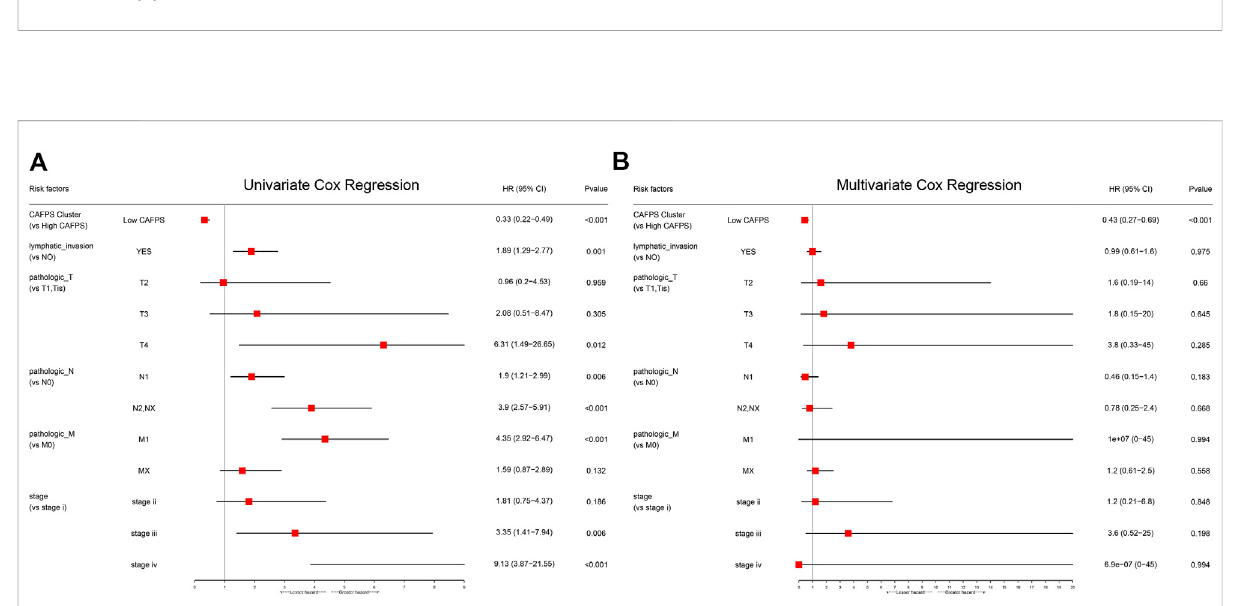
FIGURE 8 Univariate (A) andmultivariate (B) CoxanalysisandforestplotrevealedtheindependentprognosticvalueofCAFsprognosticsignature(CAFPS).